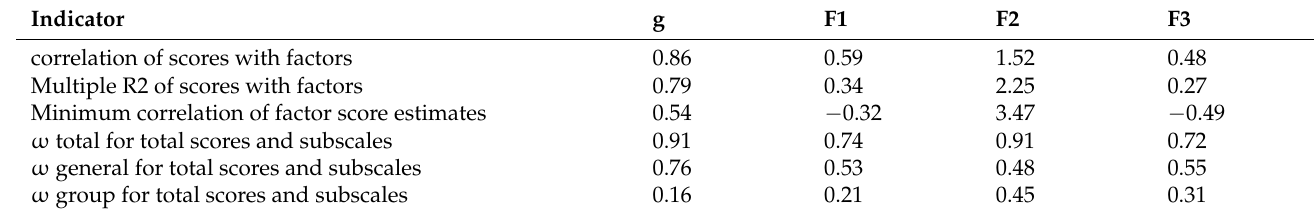
Table 13. Evaluation of exploratory factor analysis by Schmid–Leiman